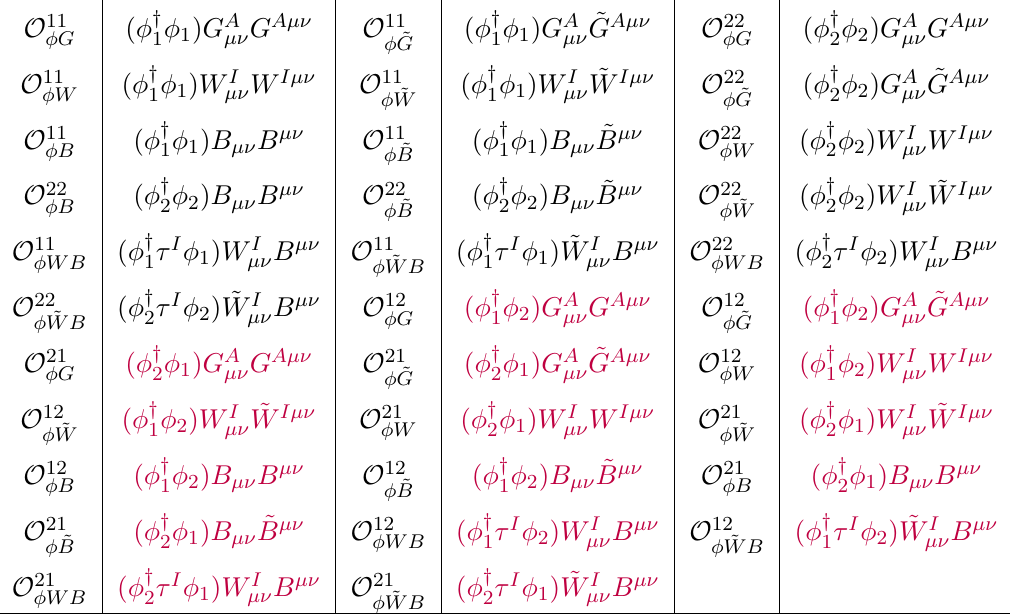
Table 5. 2HDM: (cid:30) 2 X 2 [32] class of operators.